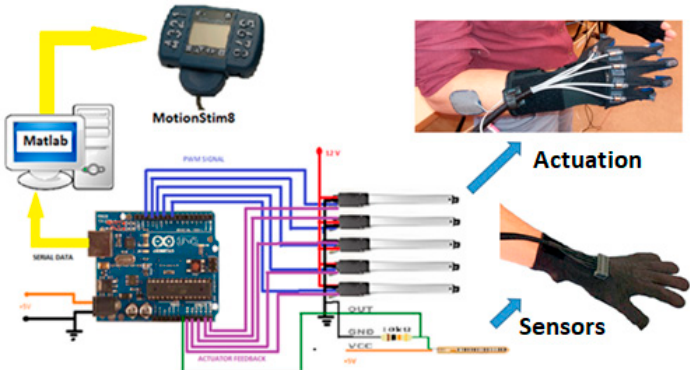
Figure 12. IHRG general architecture.